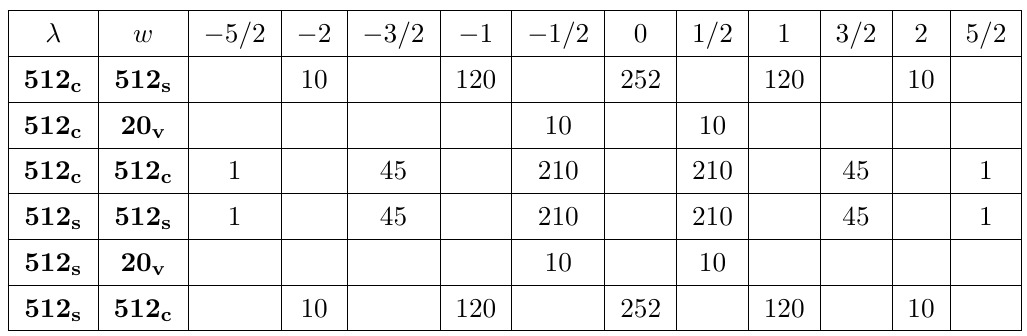
Table 13 . For any λ in a fixed reprentation, the numbers of weights w in another representation with λ · w equal to a given